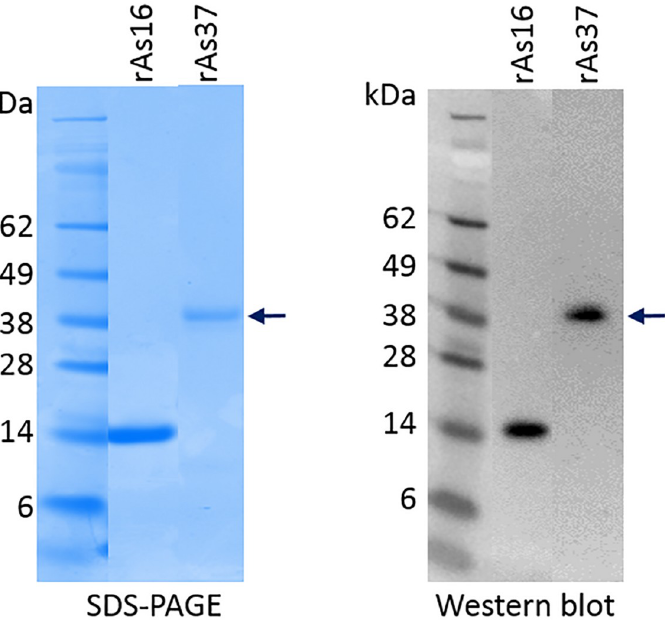
Fig 1. SDS-PAGE of recombinant As16 and As37 expressed in E . coli (2 μ g) and Western blot of recombinant proteins (50 ng) recognized by sera from mice infected with A . suum eggs (diluted